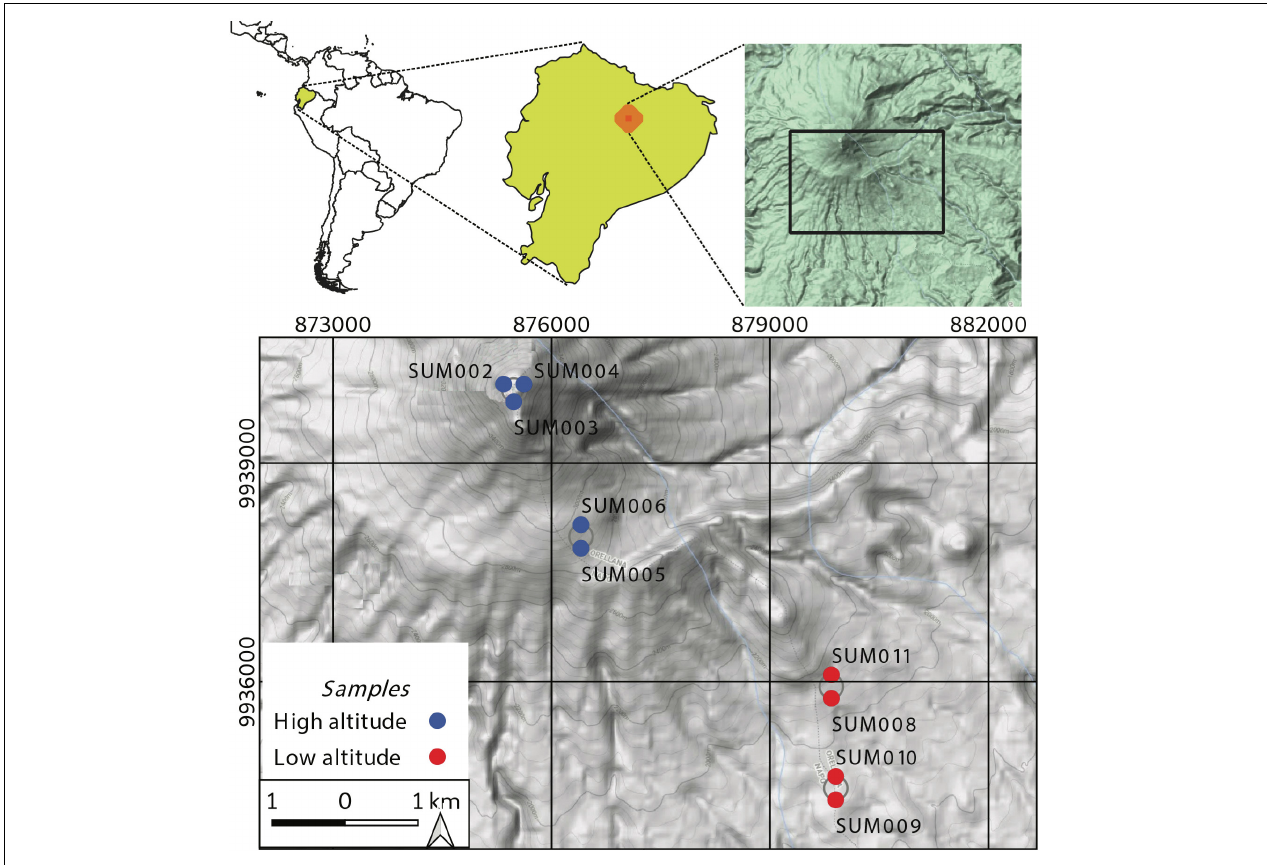
FIGURE 1 | Sampling locations along an elevational gradient in the Sumaco Volcano. Locations that were close together are represented as points in a circle. Samples have been classified into two altitudinal categories, above (blue) and below 2900 m.a.s.l.